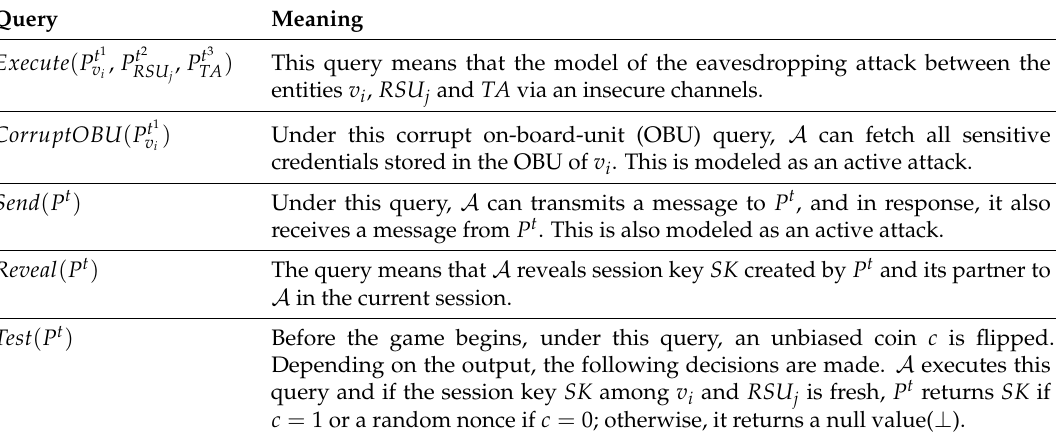
Table 2. Various queries and their